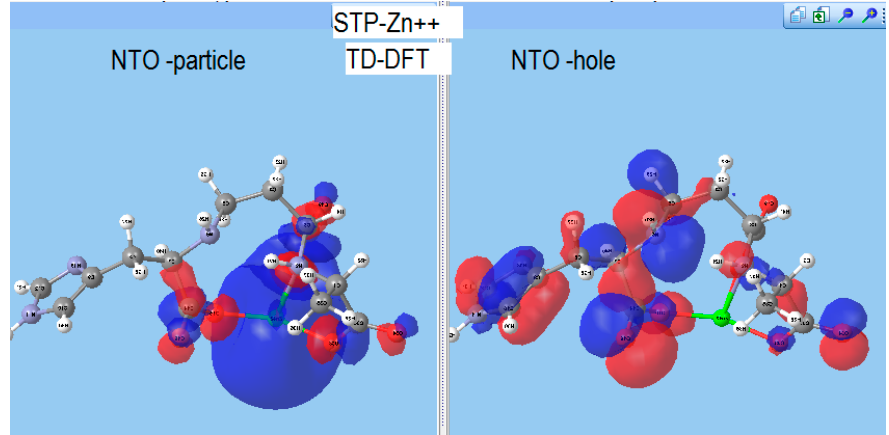
Figure 8. Natural transition (molecular) orbitals (NTOs) corresponding to FMOs of STP–Zn (cf. text).